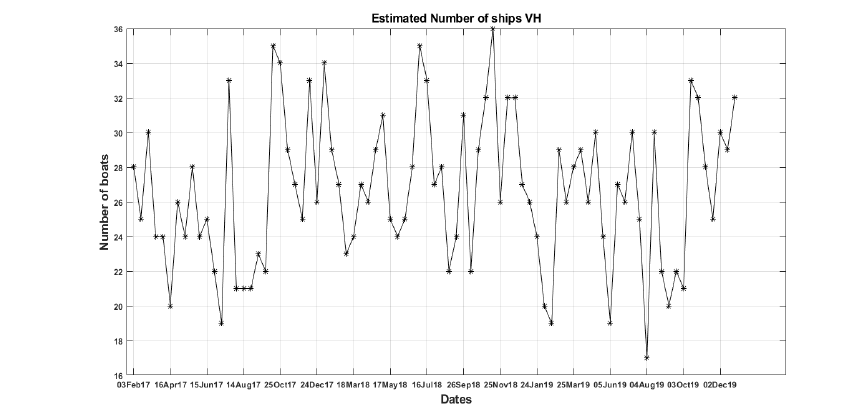
Figure 21. Estimated number of ships per